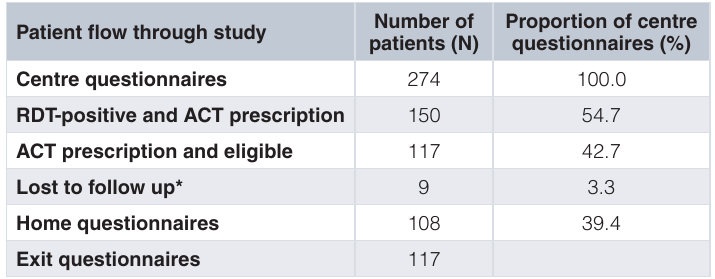
Table 2. Patient flow through